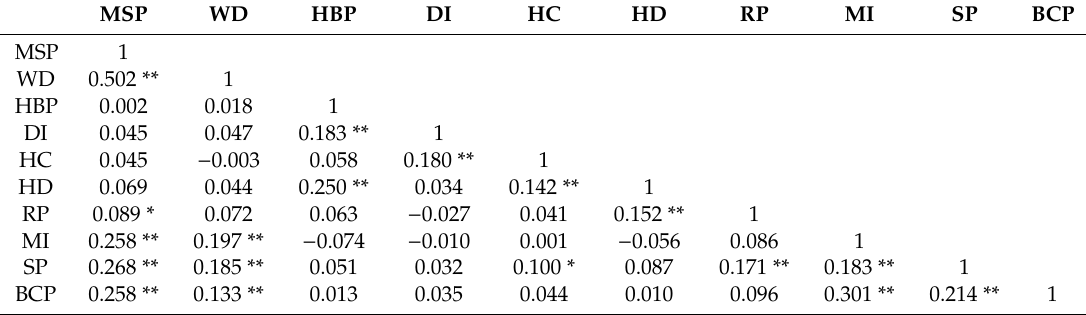
Table 5. Kendall’s Tau-b biserial point correlations between MSP, stress, and physical disorders.